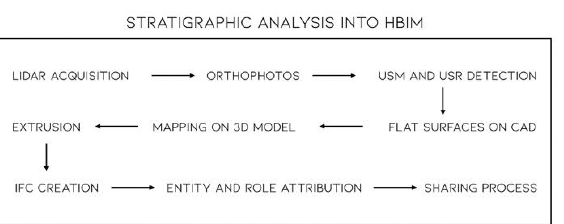
Figure 3. From stratigraphic analysis to IFC models